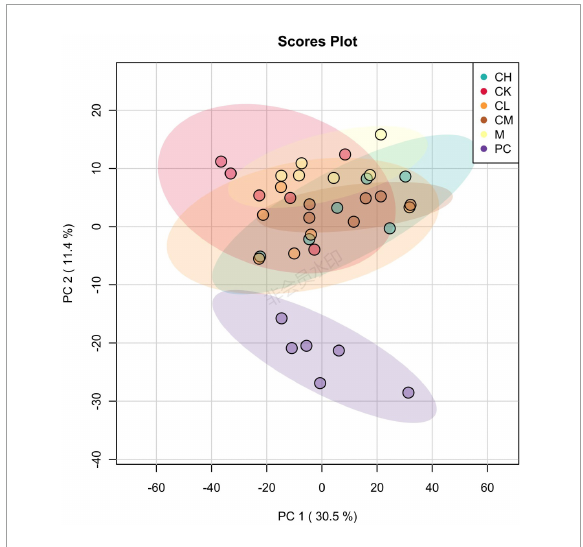
FIGURE9 Principal component analysis (PCA) diagram of gut microbiota in mice.